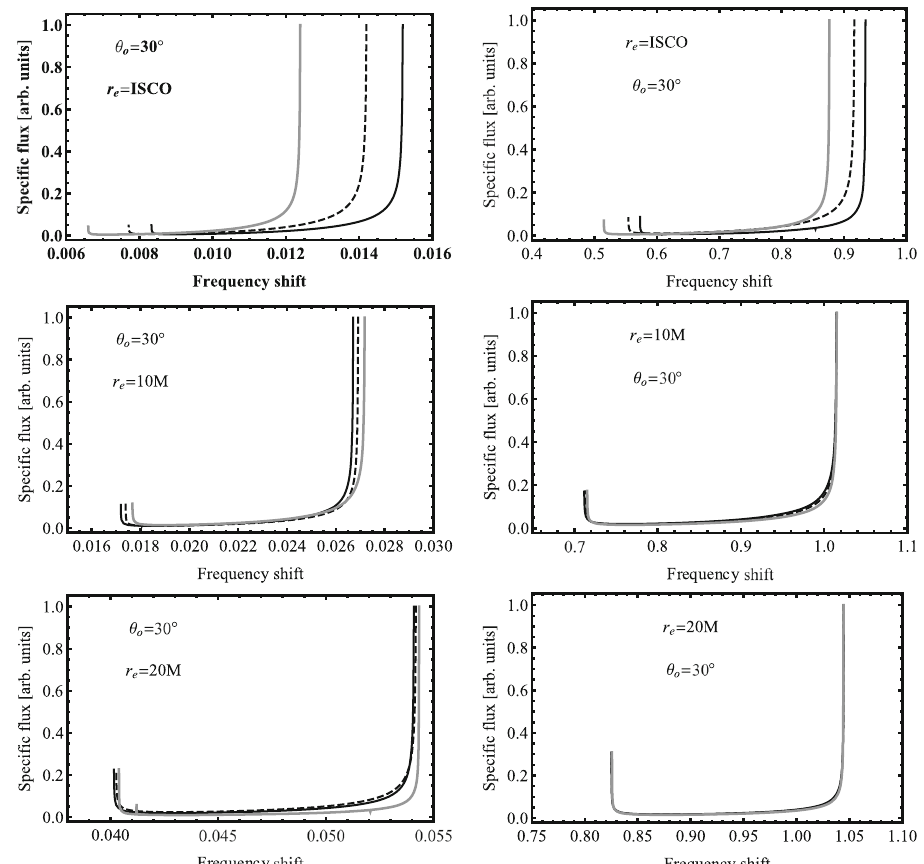
Fig. 1 Ring profiled spectral line generated for three representative values of “magnetic charge” parameter q m = 0 . 05 M (black), 0 . 5 M (black, dashed), and 0 . 768 M (thick, gray) and three Keplerian ring radii r e = r ISCO ( q m ) (top), 10 M , and 20 M (bottom). The observer inclination is θ o = 30 ◦ . The Lines generated for the effective (spacetime) geometry are presented in the left (right) column in the present and the following